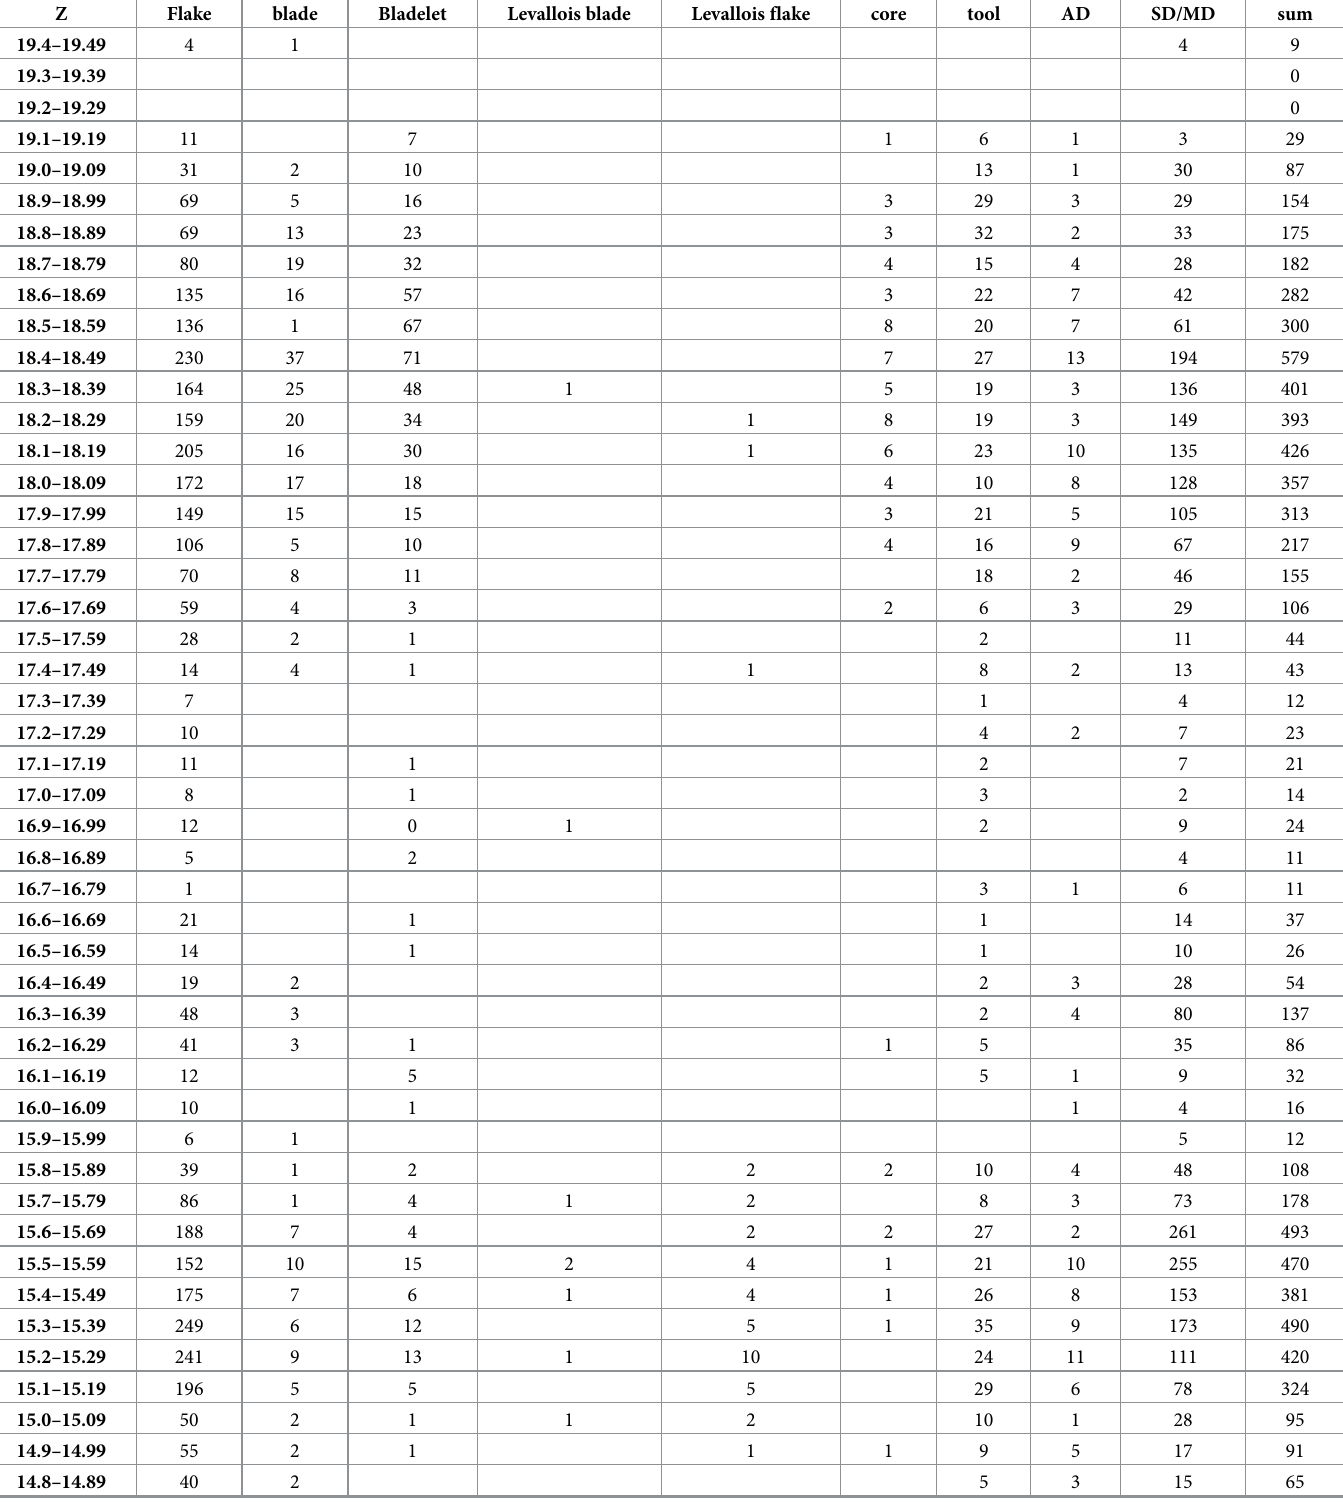
Table 4. All lithic artifacts from the East